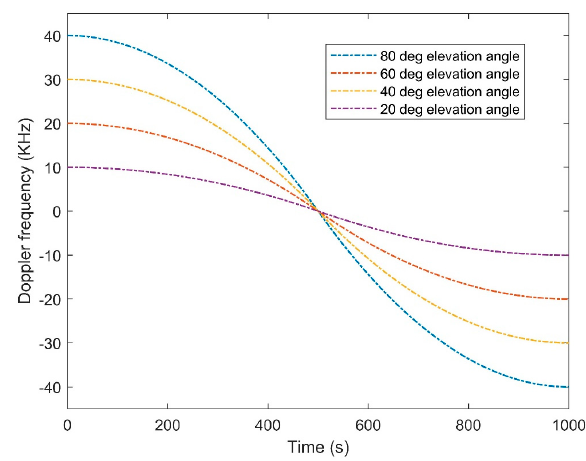
Figure 13. Approximation of the Doppler curve for LEO downlink signals in di ff erent elevation angles.